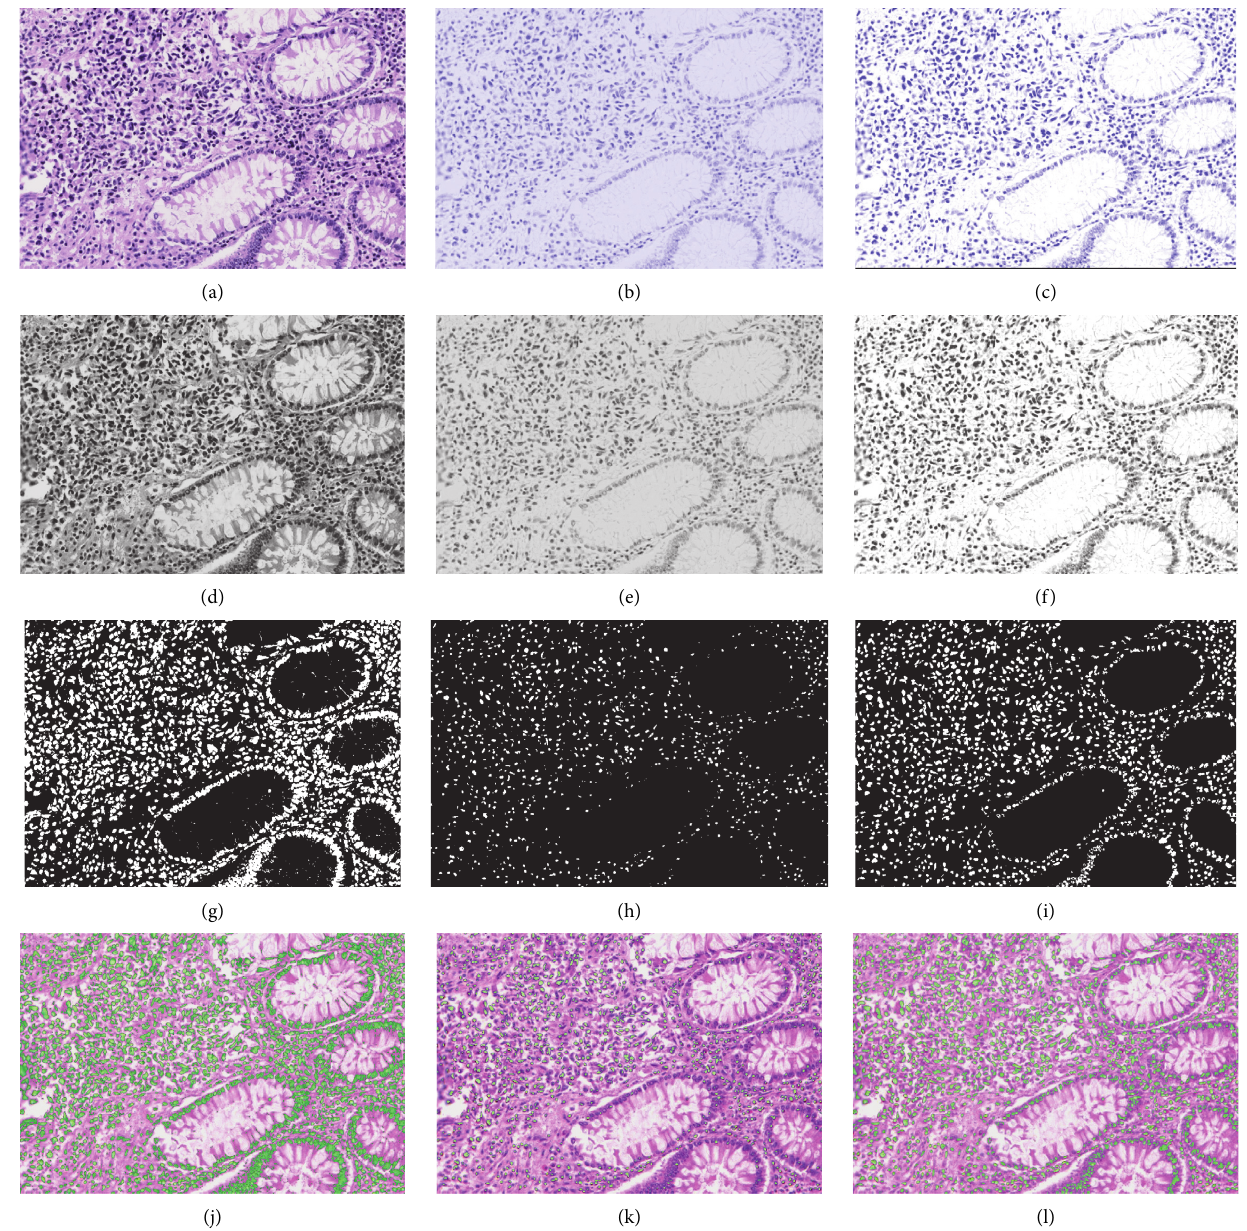
Figure 9: Nucleus segmentation of H-stain images based on three stain separation methods: (a–c) H-stain images based on different methods, (d–f) grayscale image, (g–i) binary image, and (j–l) segmentation mask overlaid on the original pathological